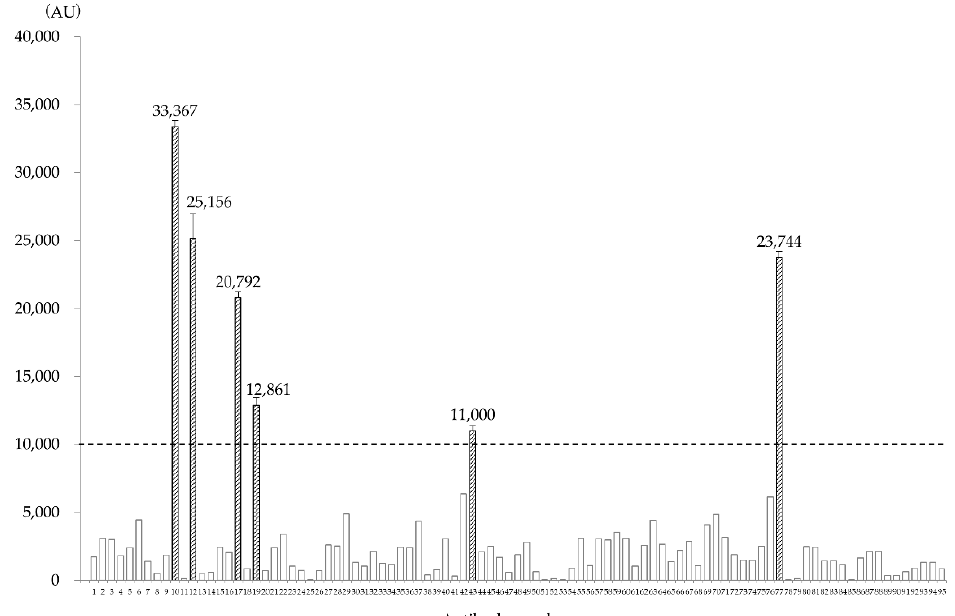
Figure 1. Measurement of fluorescence intensity of the 95 clones prepared by the fourth screening of the secondary human multicentric osteosarcoma (HMOS-P) using fluorescence probe-based enzyme-linked immunosorbent assay (ELISA). Among these, six clones showed a fluorescence intensity ≥ 10,000 arbitrary units (AU).